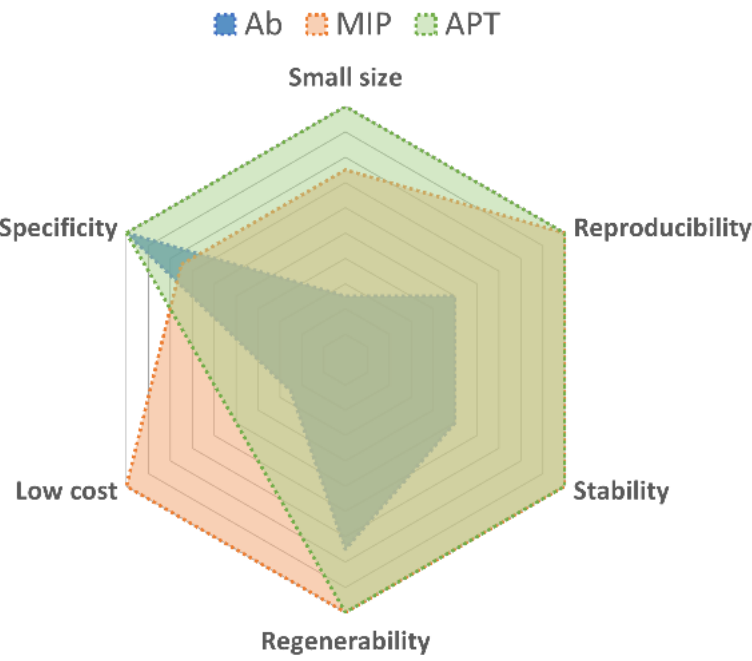
Figure 1. Comparison of different MREs based on the most significant parameters for biosensing. Strengths are relative to the most performing MRE for each parameter, and the higher value is at the periphery of the plot.